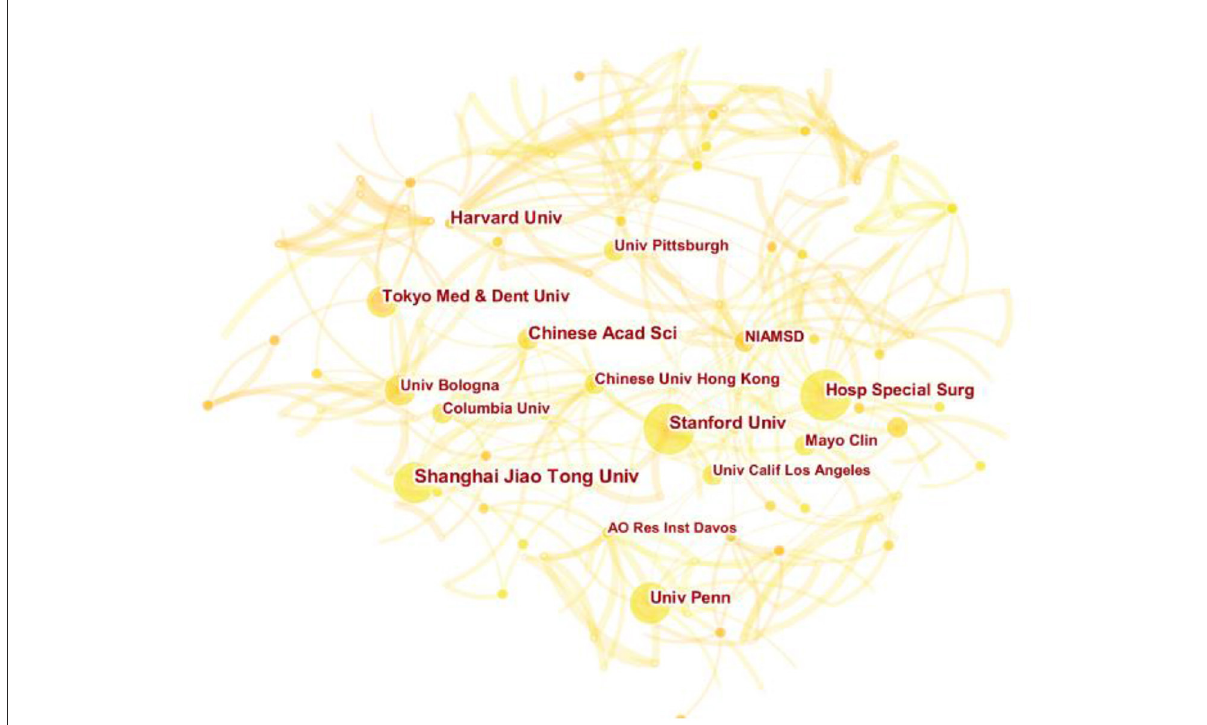
FIGURE4 The cooperation network map of institutions related to MSCs in orthopedics from